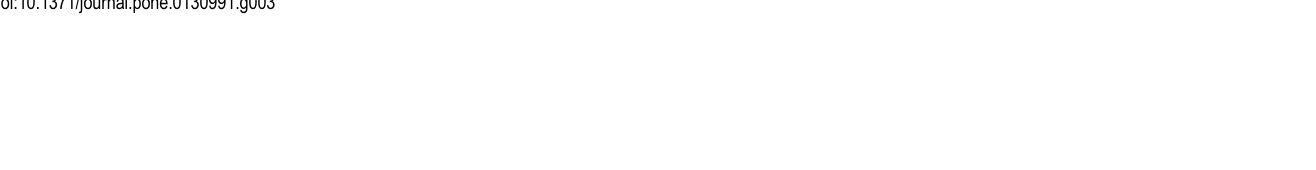
PLOS ONE | DOI:10.1371/journal.pone.0130991 June 26,